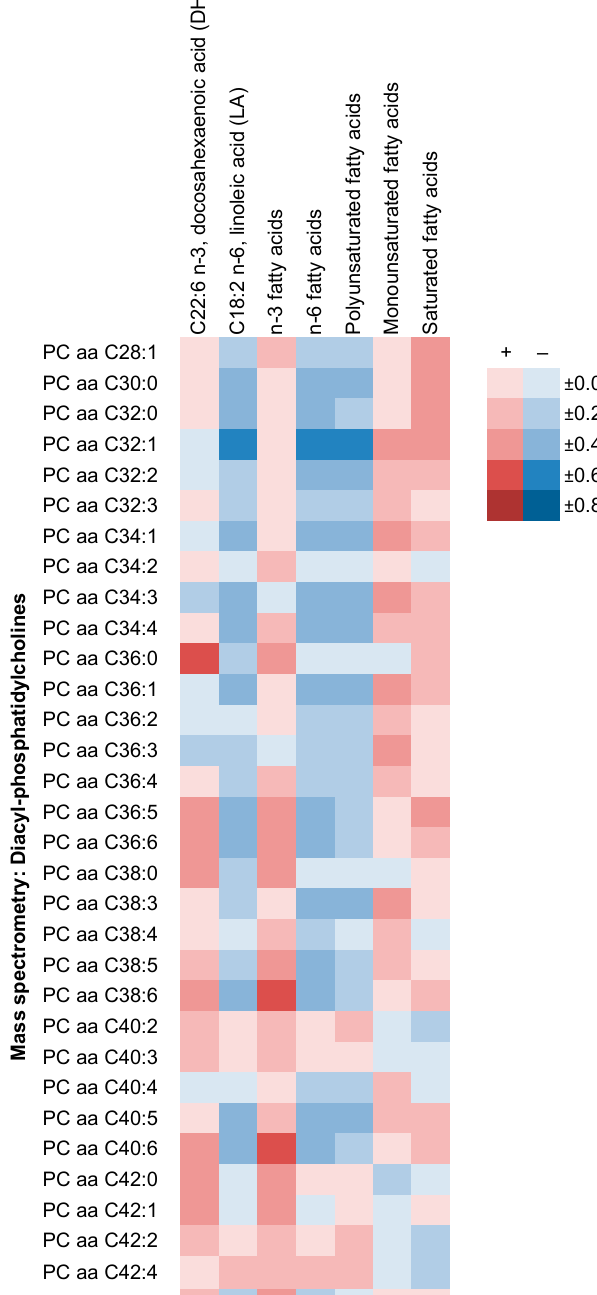
Figure 7. Correlations of NMR fatty acid ratios with MS diacyl-phosphatidylcholine concentrations. Plasma diacyl-phosphatidylcholine (PC aa) concentrations were measured using the mass spectrom- etry based Absolute IDQ ® p180 Kit (Biocrates Life Sciences AG, Innsbruck, Austria) [20]. “Cx:y” denotes the total number of carbon atoms and double bonds in the two fatty acid side chains of the phosphatidylcholines. Further details are seen in Table